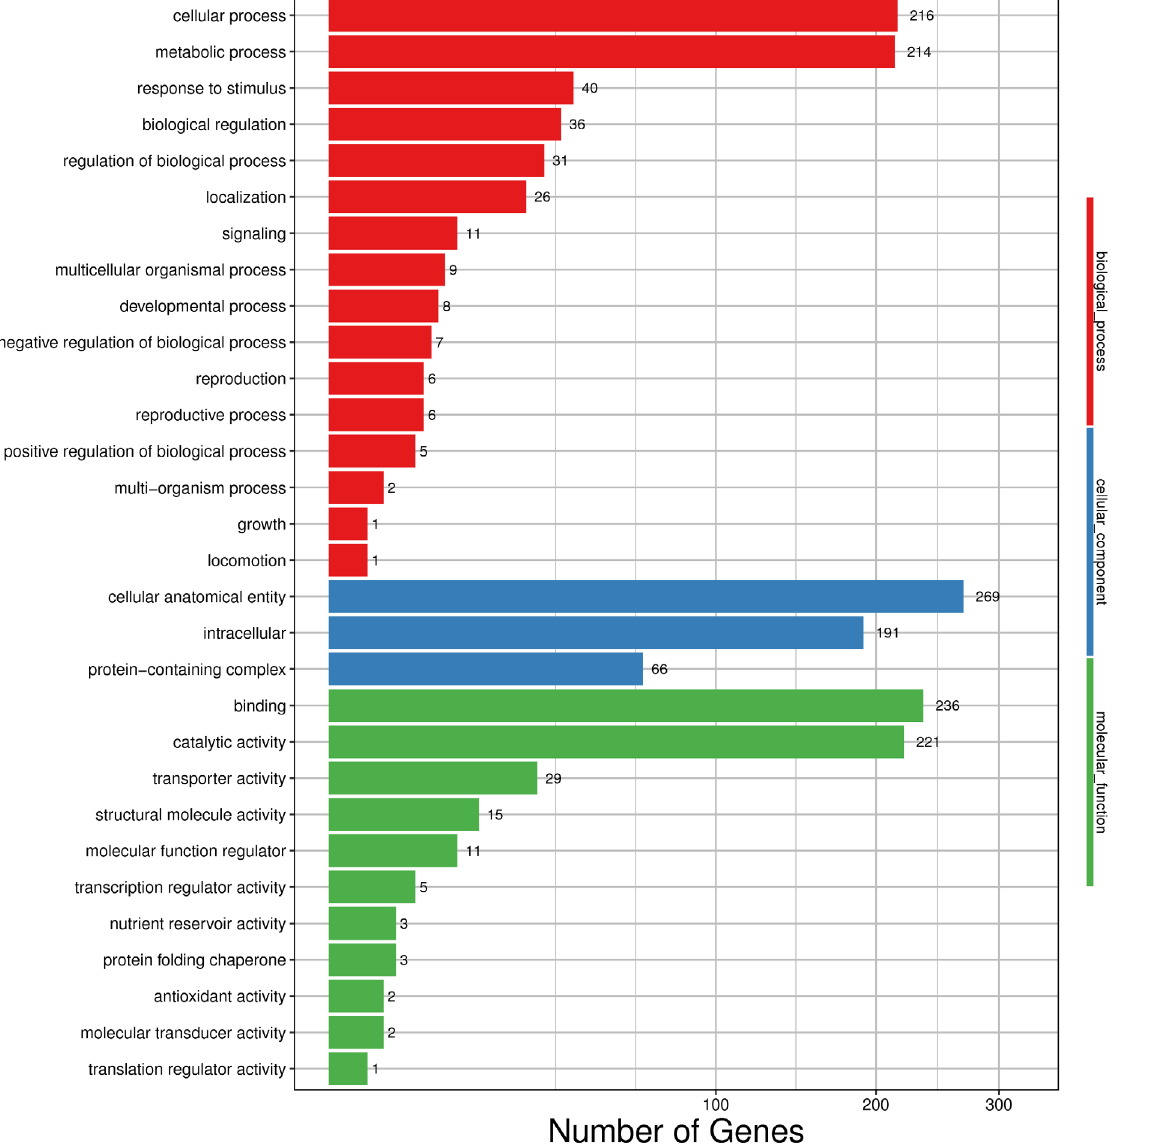
Figure 2. Figure shows gene ontology classification of genes differentially expressed in high-B (TB 10 mM)-treated shoots of the T. dicoccum (Td) genotype PI94655 compared to 3.1 µM B (control) treatment. While the gene ontology term is denoted by Y axis, the X axis denotes the number of DEG in the biological process, cellular component, and molecular